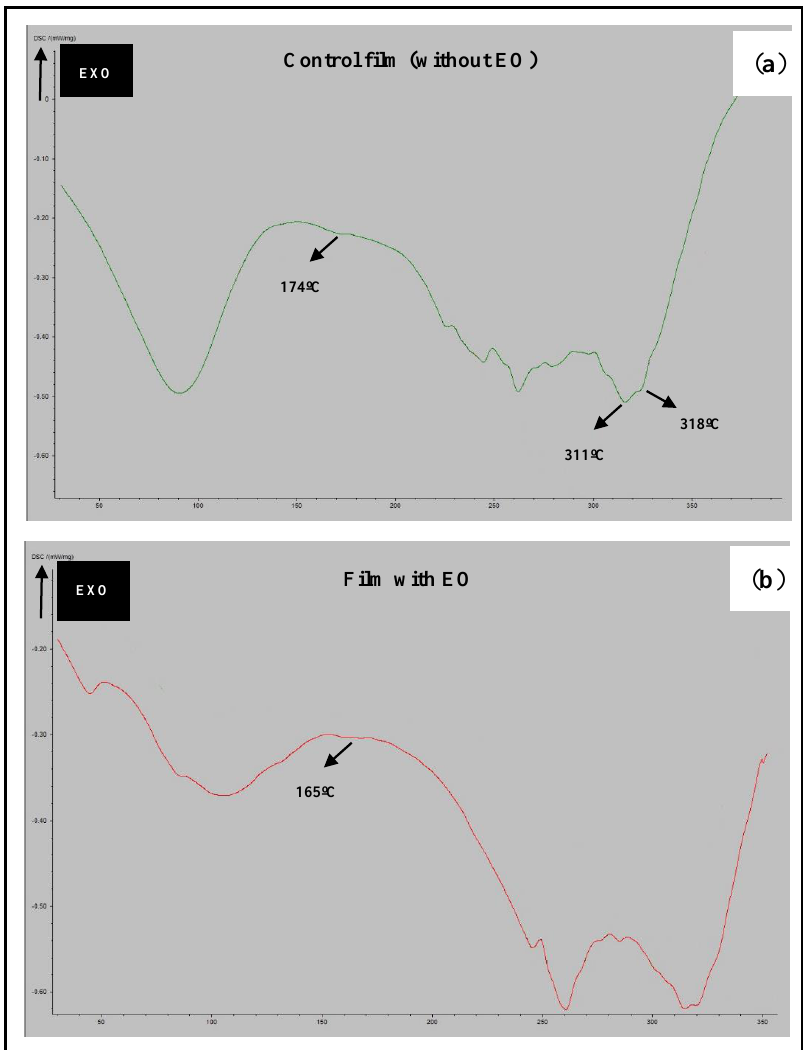
Figure 3. DSC curves of the films: control film (without EO) ( a ), and film with EO ( b